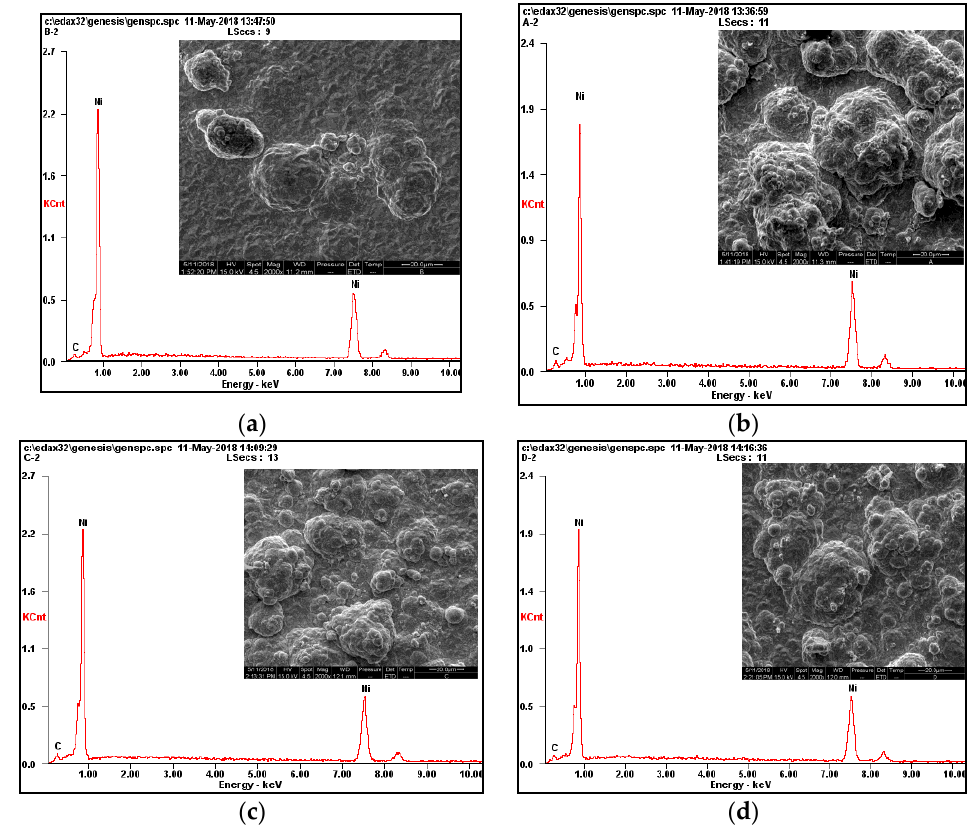
Figure 6. Scanning electron microscope energy spectrum analysis of composite plating prepared at different nanodiamond concentrations in the plating solution (2000×): ( a ) 1 g/L, ( b ) 5 g/L, ( c ) 10 g/L and ( d ) 15 g/L.